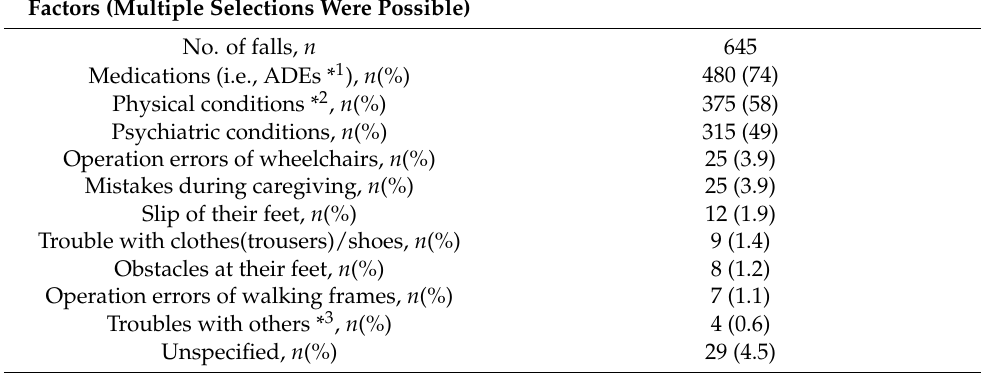
Table 2. Factors influencing each